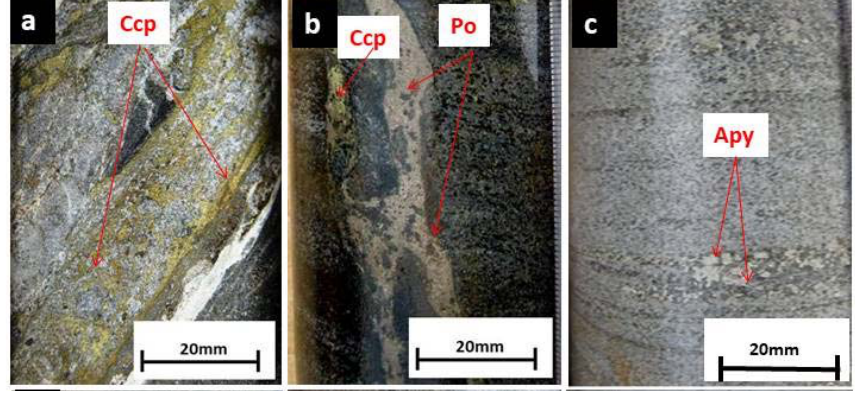
Figure 5. Field photographs showing ( a ) foliation parallel and vein (quartz-carbonate) filled chal- copyrite in felsic meta-volcanic rock; ( b ) pyrrhotite and chalcopyrite occurring as veins within felsic